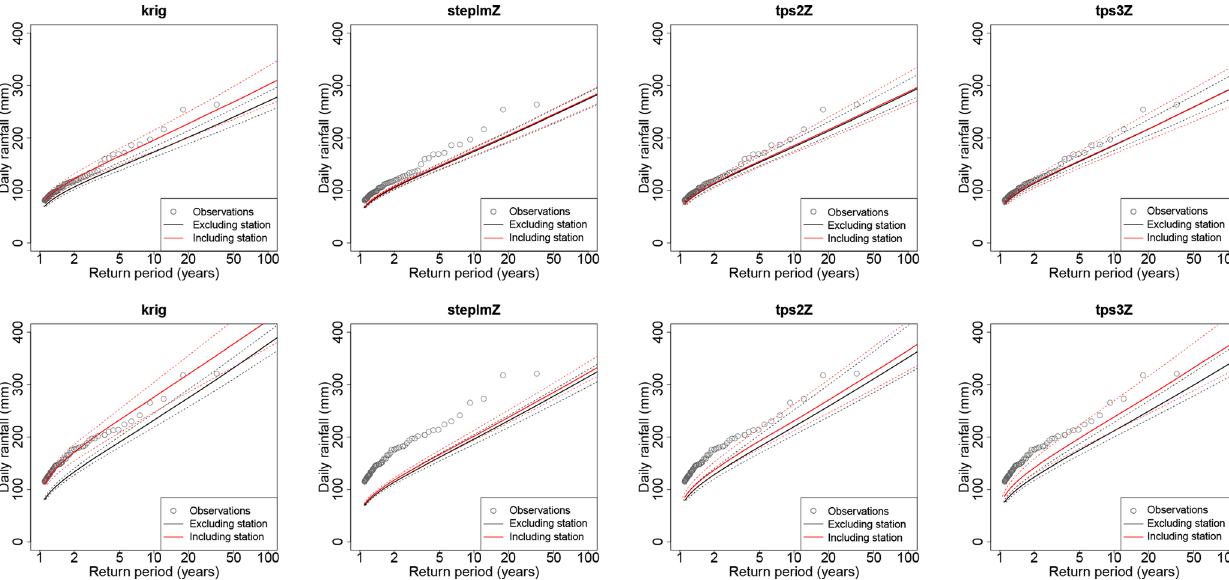
Figure 11. Cases of Antraigues (panels a – d ) and Mayres (panels e – h ) when G s,k are Gamma distributions with S = 2 and K = 3 whose parameters are interpolated with either kriging without external drift (krig), a stepwise linear model (steplmZ), a bivariate thin plate spline with drift (tps2Z), or a trivariate thin plate spline (tps3Z). The dotted lines show the 95% envelope of return level estimates over the 100 subsamples. The plain line shows the median estimates. In black, each interpolation is based on half the data of the other stations, excluding the considered station. In red, interpolation is based on half the data of all the stations, including the considered station. The gray points show the full sample (35 years for both